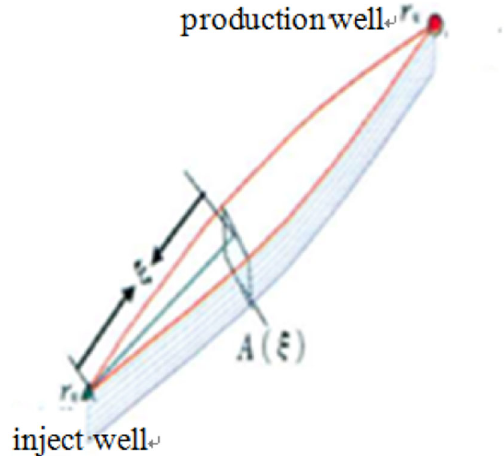
Fig. 10 Diagram of stream tube